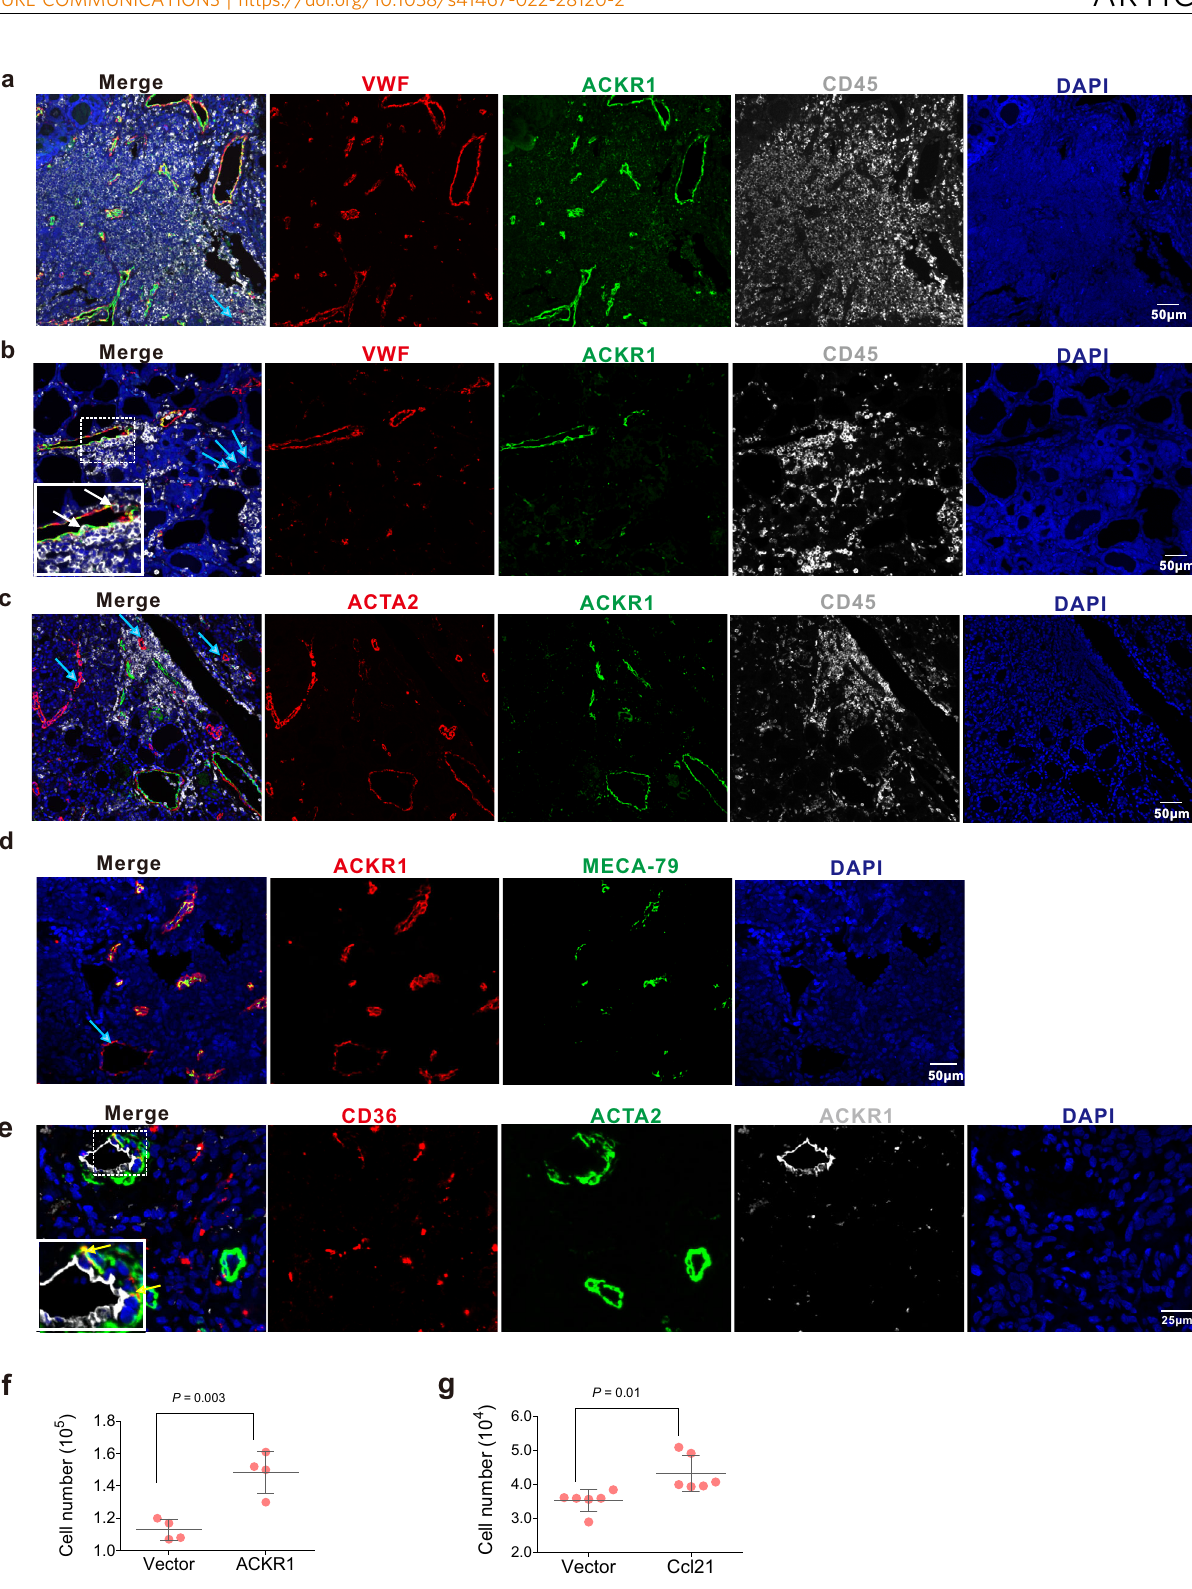
were performed by bulk RNA-seq on thyroid para-tumor tissues of 16 HT patients and 50 non-HT controls who underwent surgery due to thyroid tumor (Supplementary Data 4). As expected, the upregulated genes in HT thyroid tissues showed enriched GO process of lymphocyte activation, adaptive immune response, immune effector process, leukocyte migration, as well